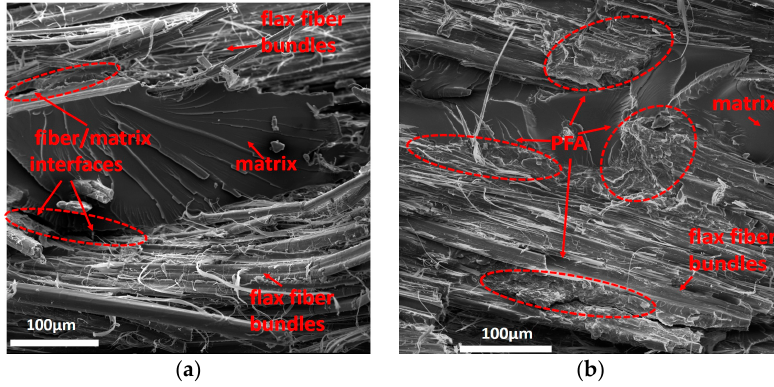
Figure 6. ( a ) Morphology of fracture surface of untreated flax fiber composites; and ( b ) morphology of fracture surface of FA treated flax fiber composites.